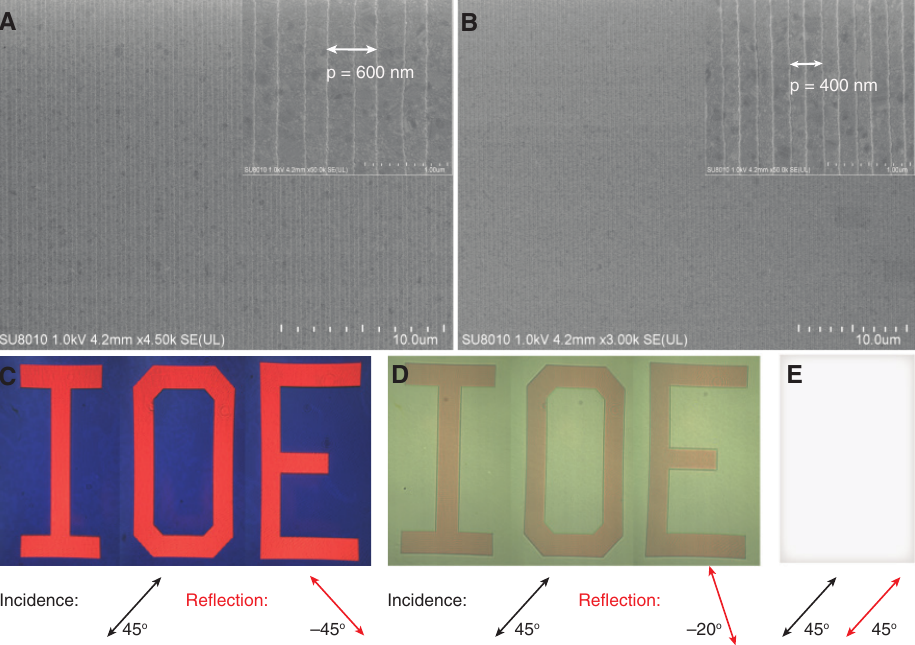
Figure 3: SEM images of the building blocks for the logo with period of (A) 600 nm and (B) 400 nm. (C–E) Microscopic images of the sample for 45 ° polarized incident light. The polarization direction of the reflection light is (C) −45 ° , (D) −20 ° , and (E) 45 °